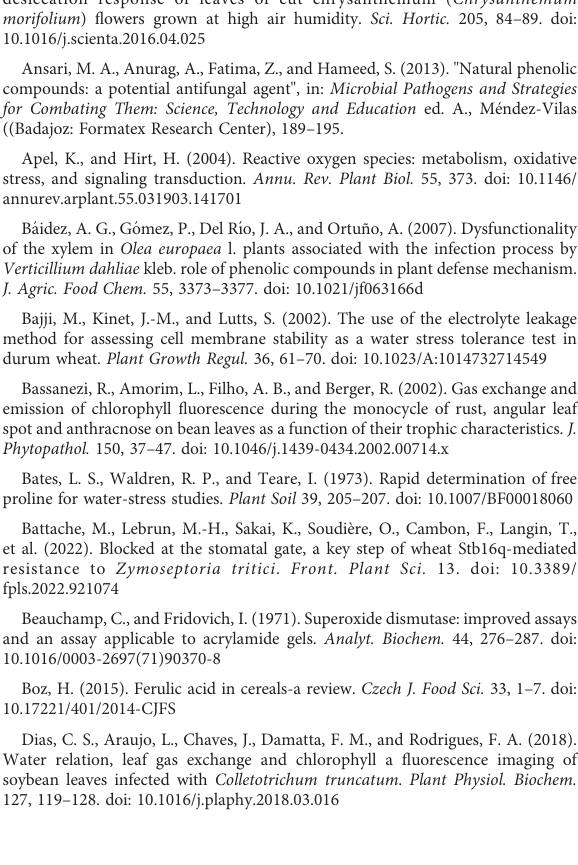
produced on the necrotic lesions. Pictures were taken at 2, 4, 8, 12, 16, and 21 days post-inoculation. Error bars are SD. SUPPLEMENTARY FIGURE 2 Spider plot of the chlorophyll fl uorescence parameters in wheat cv. Sha fi r inoculated by distilled water(Mock), WT IPO323, and D AvrStb6#33 after 2, 4, 8, 12, 16, and 21 days post-inoculation. SUPPLEMENTARY FIGURE 3 A schematic modelillustrating changes that occurred in the photosynthetic parameterincv.Sha fi rinoculatedbyIPO323WTor D AvrStb6#33 alongwith the Chlorophyll fl uorescence images of infected wheat leaves taken at 2, 4, 8, 12, 16, and 21 dpi. Increases or declines in parameter ’ s amount are represented by size changes of boxes embedded each parameter. SUPPLEMENTARY FIGURE 4 The impact of AvrStb6-Stb6 interaction on OJIP curve of cv. Sha fi r inoculated by distilled water (Mock), WT IPO323, and D AvrStb6#33 . Data are shown as fl uorescence intensity. SUPPLEMENTARY FIGURE 5 Graphical representation of a correlation matrix of initial plant enzymatic and non-enzymatic antioxidant as well as photosynthesis parameters in cv. Sha fi r inoculated either with D AvrStb6#33 (A) or IPO323 (B) . Red color represents positive correlation whereas blue represents negative correlation. Color intensity is proportional to the correlation, which depicted in the legend at the